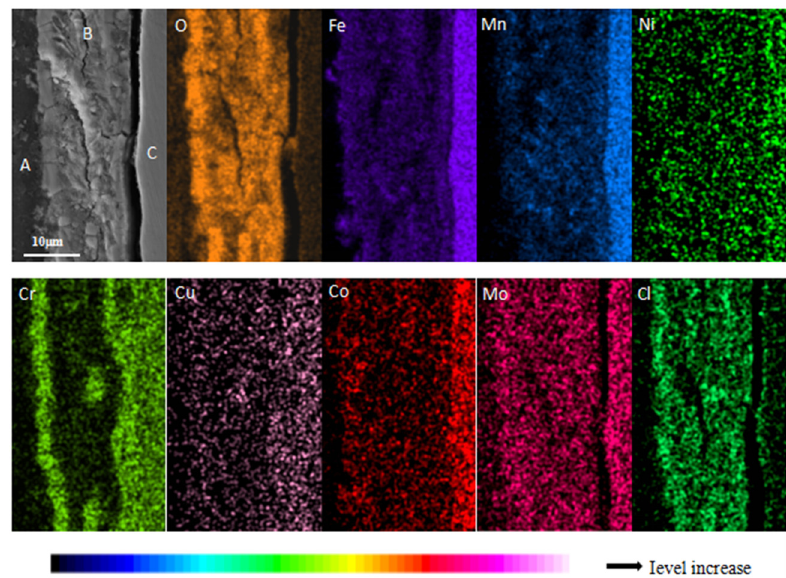
Figure 11: Cross section morphology and element distribution of corrosion products after corrosion for 600 h in 10.5% NaCl solution. A: epoxy resin, B: rust layer, C: steel